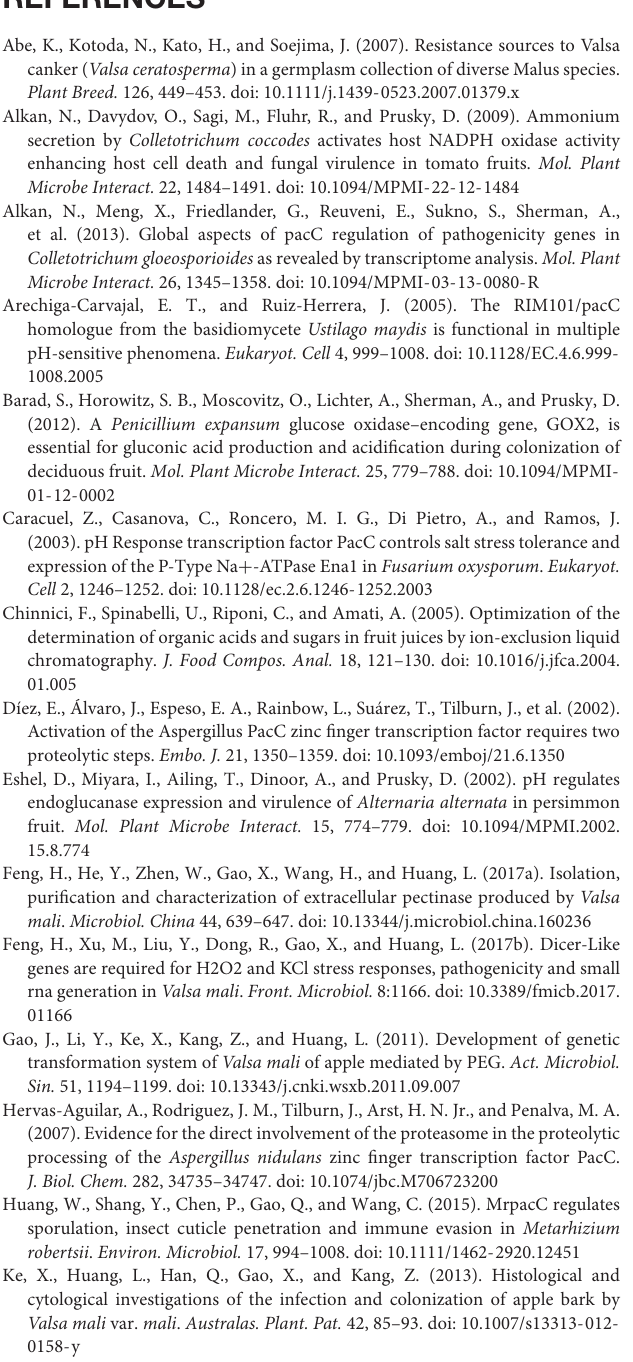
TABLE S1 | Pectinase genes for expression. TABLE S2 | Primers used for deletion, complementation, and gene